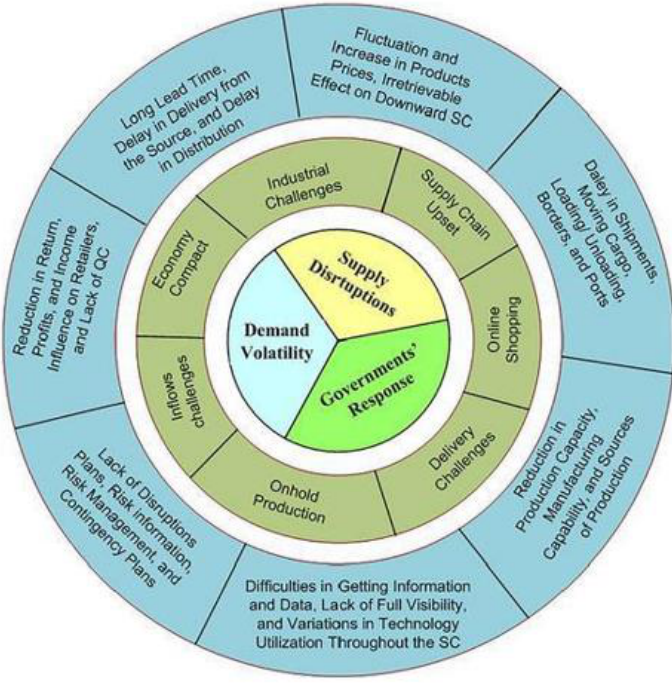
Figure 5. Framework of the